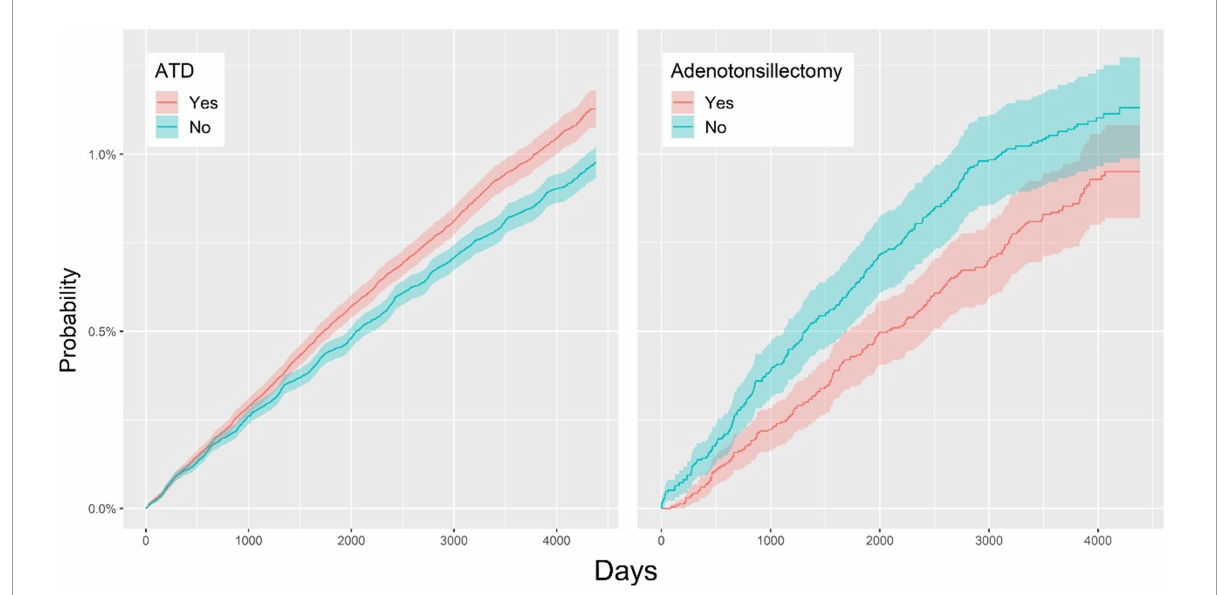
FIGURE2 Overall cumulative incidence rates for vitiligo in the ATD and non-ATD groups (Left) ; cumulative hazard plot of vitiligo in the adenotonsillectomy and non-adenotonsillectomy groups (Right) . ATD, adenotonsillar